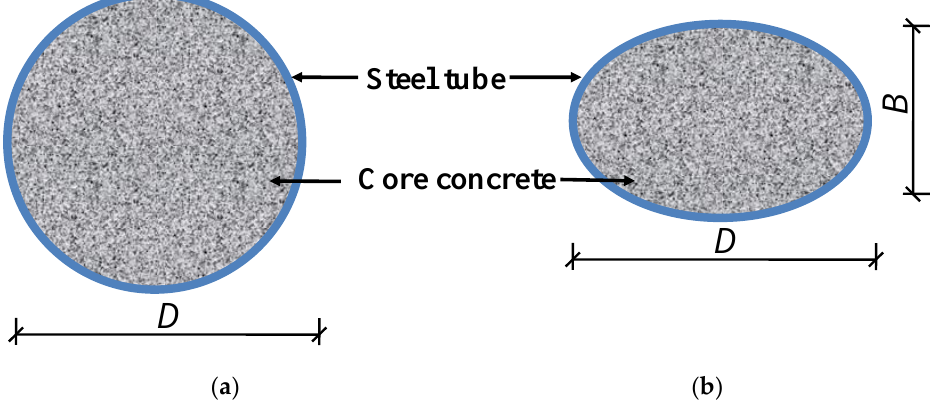
Figure 1. Cross-sections of two typical specimens. ( a ) Circular; ( b ) Elliptical.